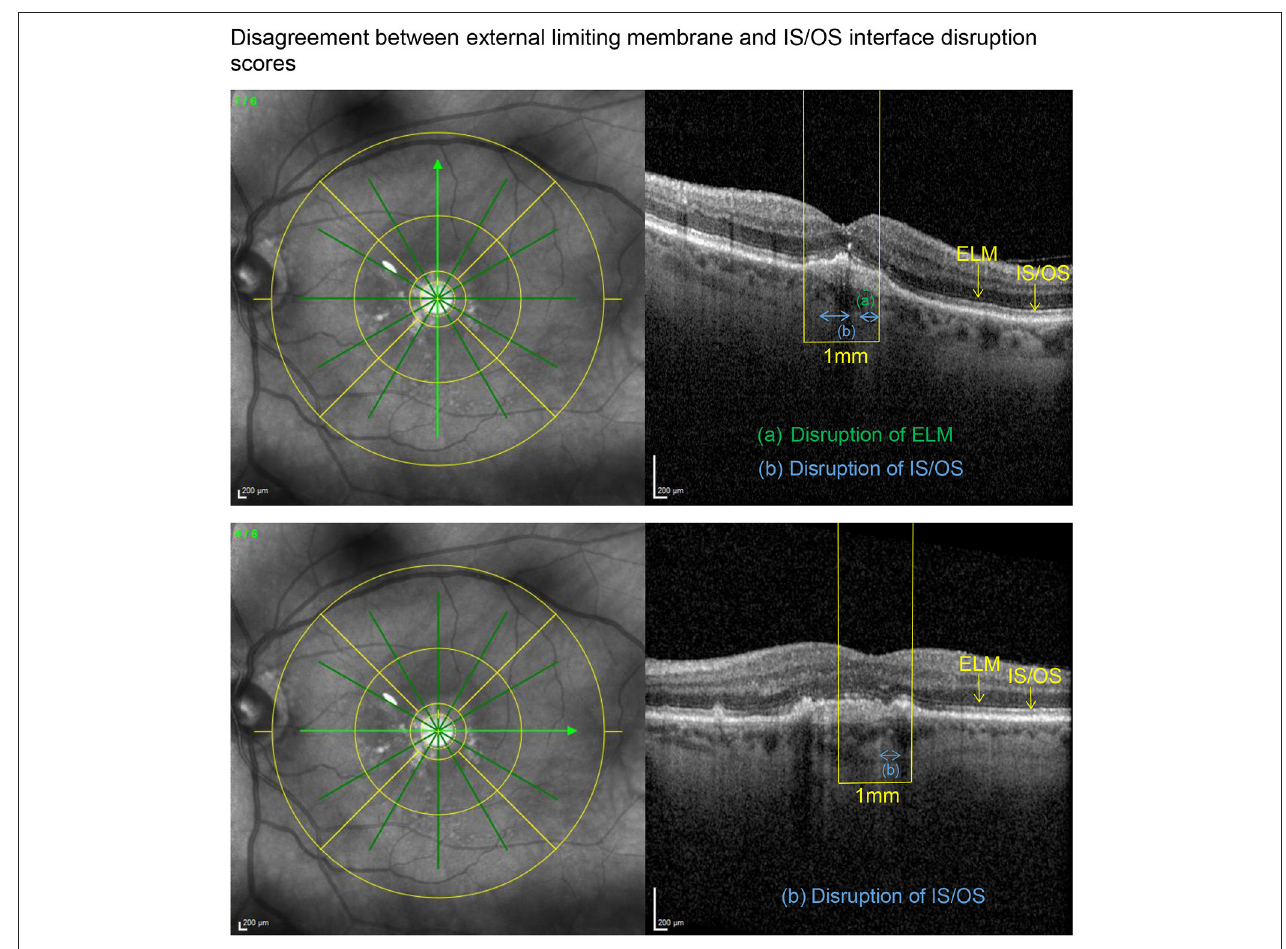
FIGURE 2 | Applying the grading system to an eye with a preserved BCVA of 80 letters, this example illustrates an only mildly disrupted ELM (impairment score of 0.5) in the presence of an already altered IS/OS interface (disruption score of 1.5).